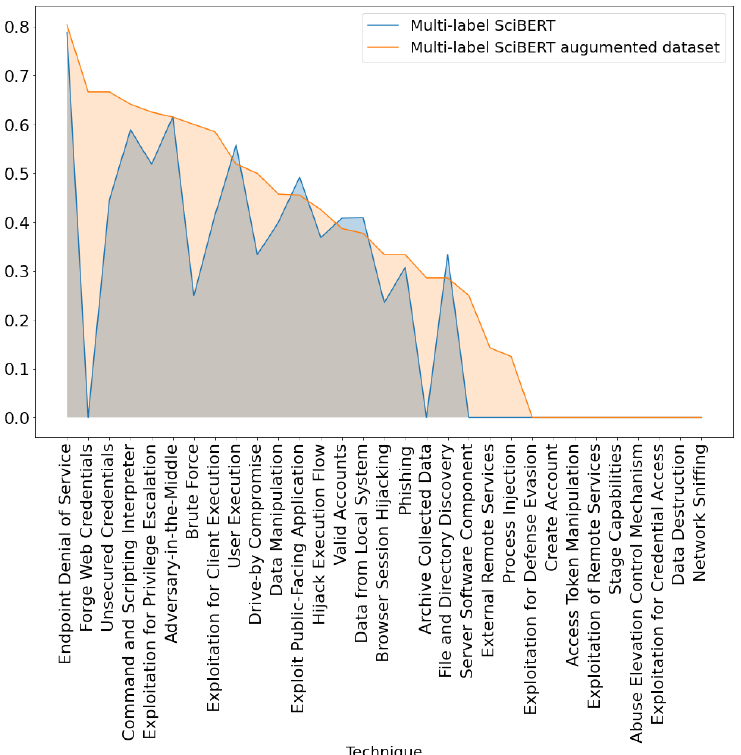
Figure 8. Comparing F1-score per technique between SciBERT model trained on initial and aug- mented